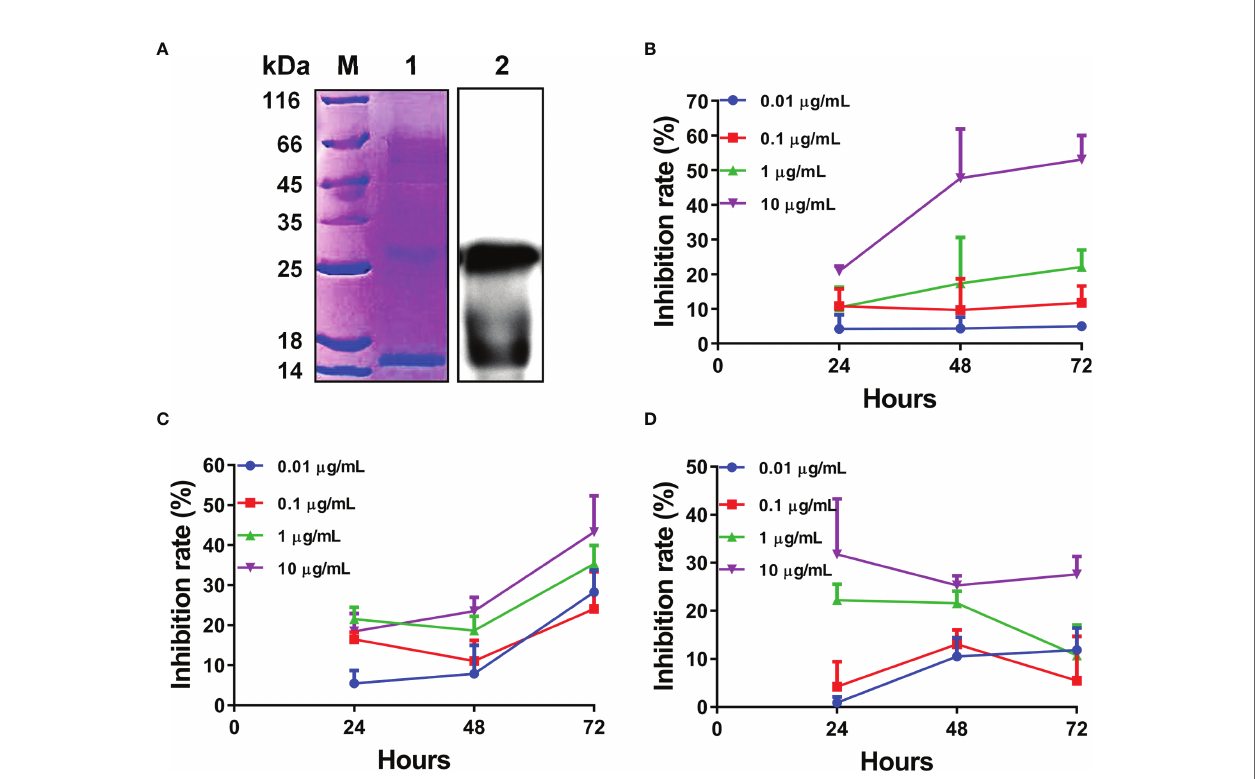
FIGURE 5 | Expression and biological activity analysis of recombinant L-TGF- b 2 mature peptide. (A) Detection of L-TGF- b 2 recombinant protein using SDS-PAGE and immunoblotting under non-reducing conditions. The bands of rL-TGF- b 2 monomer and dimer are found at about 13 kDa and 26 kDa, respectively. (B) The inhibition rate of rL-TGF- b 2 on the proliferation of MCF-7 cells using CCK8 assay. Two-way RM ANOVA is used for statistical analysis. Time: F (2, 16) = 6.148, P = 0.0105; dose: F (3, 8) = 86.53, P < 0.0001; the interaction of time and dose: F (6, 16) = 2.886, P = 0.0421. (C) The inhibition rate of rL-TGF- b 2 on the proliferation of RAW 264.7 cells using CCK8 assay. Two-way RM ANOVA is used for statistical analysis. Time: F (2, 24) = 148.4, P < 0.0001; dose: F (3, 12) = 7.894, P = 0.0036; the interaction of time and dose: F (6, 24) = 6.049, P = 0.0006. (D) The inhibition rate of rL-TGF- b 2 on the proliferation of LPS-stimulated RAW 264.7 cells using CCK8 assay. Two-way RM ANOVA is used for statistical analysis. Time: F (2, 16) = 1.296, P = 0.3009; dose: F (3, 8) = 39.55, P < 0.0001; the interaction of time and dose: F (6, 16) = 2.753, P = 0.0493. All experiments were repeated